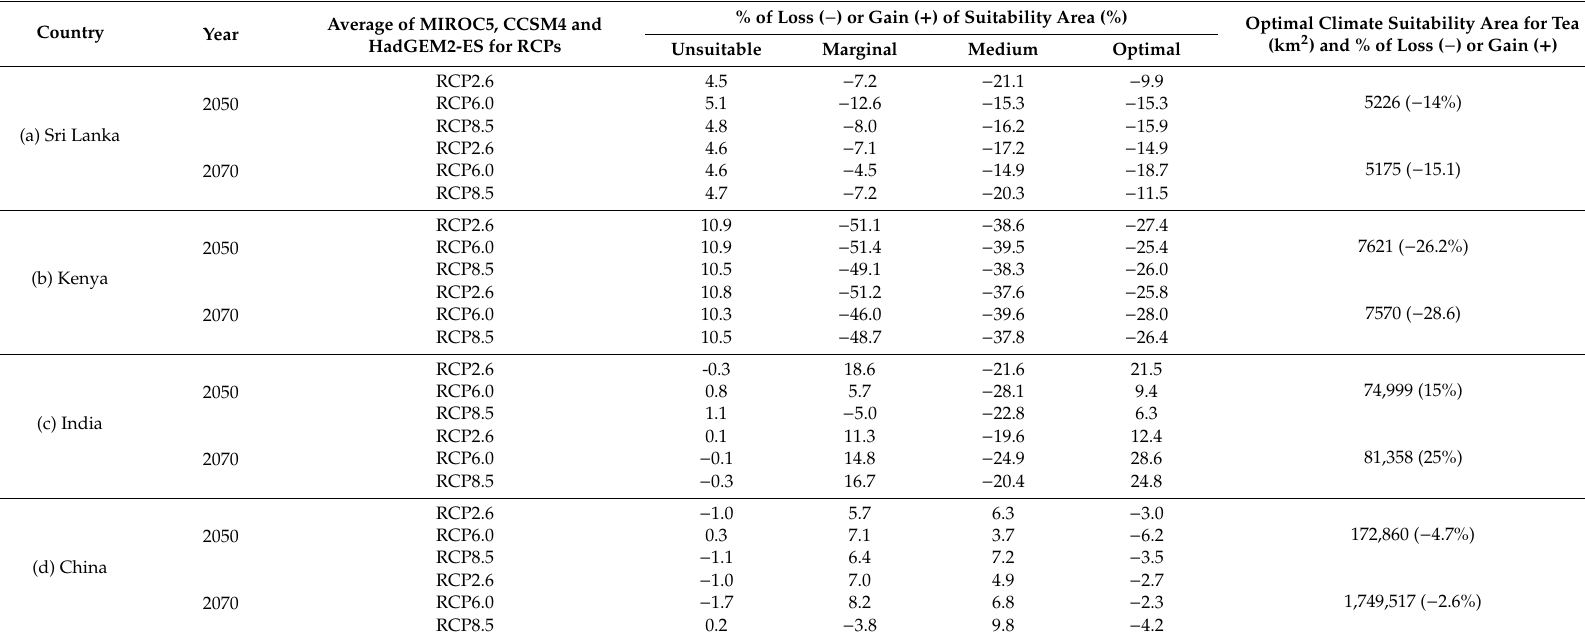
Table 4. Changes in habitat suitability areas [% of loss ( − ) or gain ( + )] for Camellia sinensis by 2050 and 2070. Country Year Average of MIROC5, CCSM4 and HadGEM2-ES for